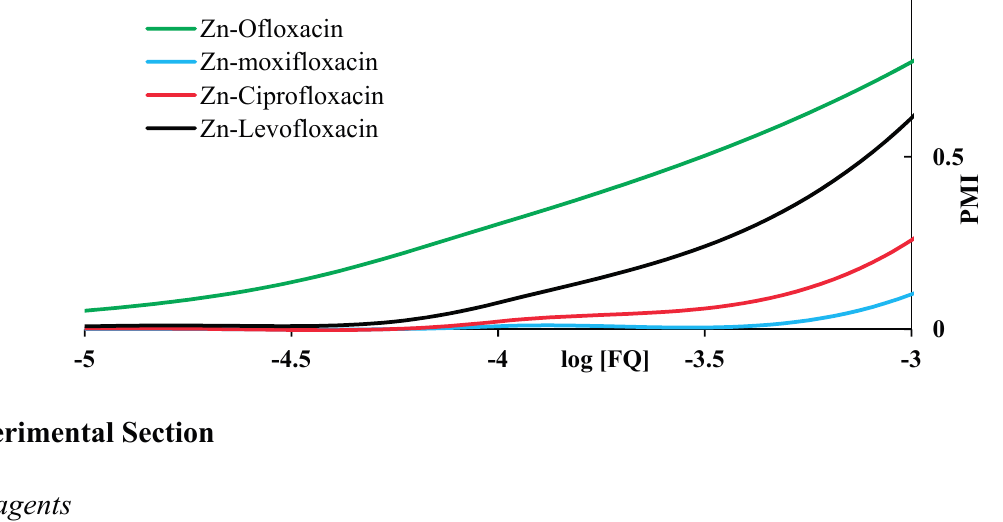
Figure 15. The effect of fluoroquinolone ligands on plasma mobilization of